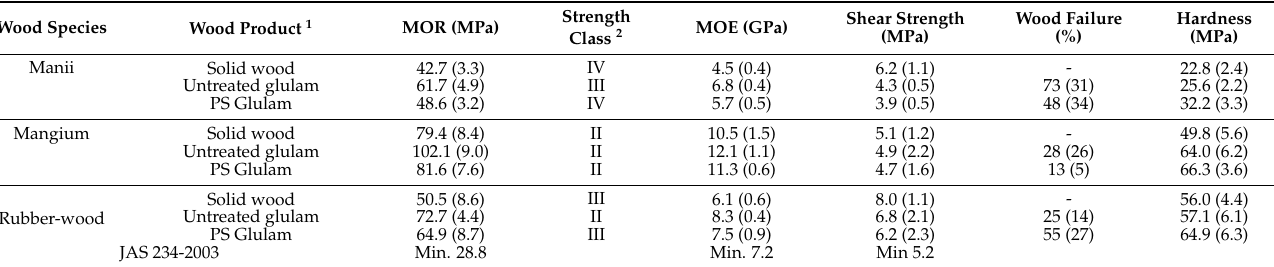
Figure 5. Strength-tested specimens of polystyrene-impregnated rubber-wood glulam. Table 4. Mechanical properties of each wood species and wood product.